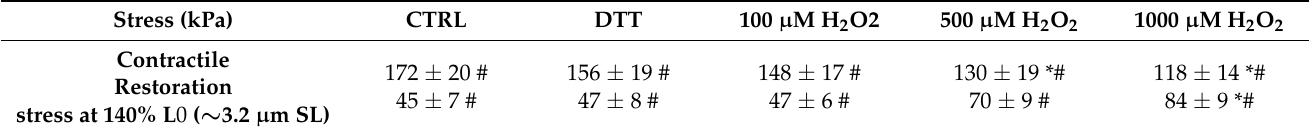
Table 2. Comparison of maximum contractile stress produced in a Ca 2+ saturated environment and maximum restoration stress in response to strain. Significance indicated as follows: * = p < 0.05 vs. CTRL, and # = p < 0.05 active vs. passive.